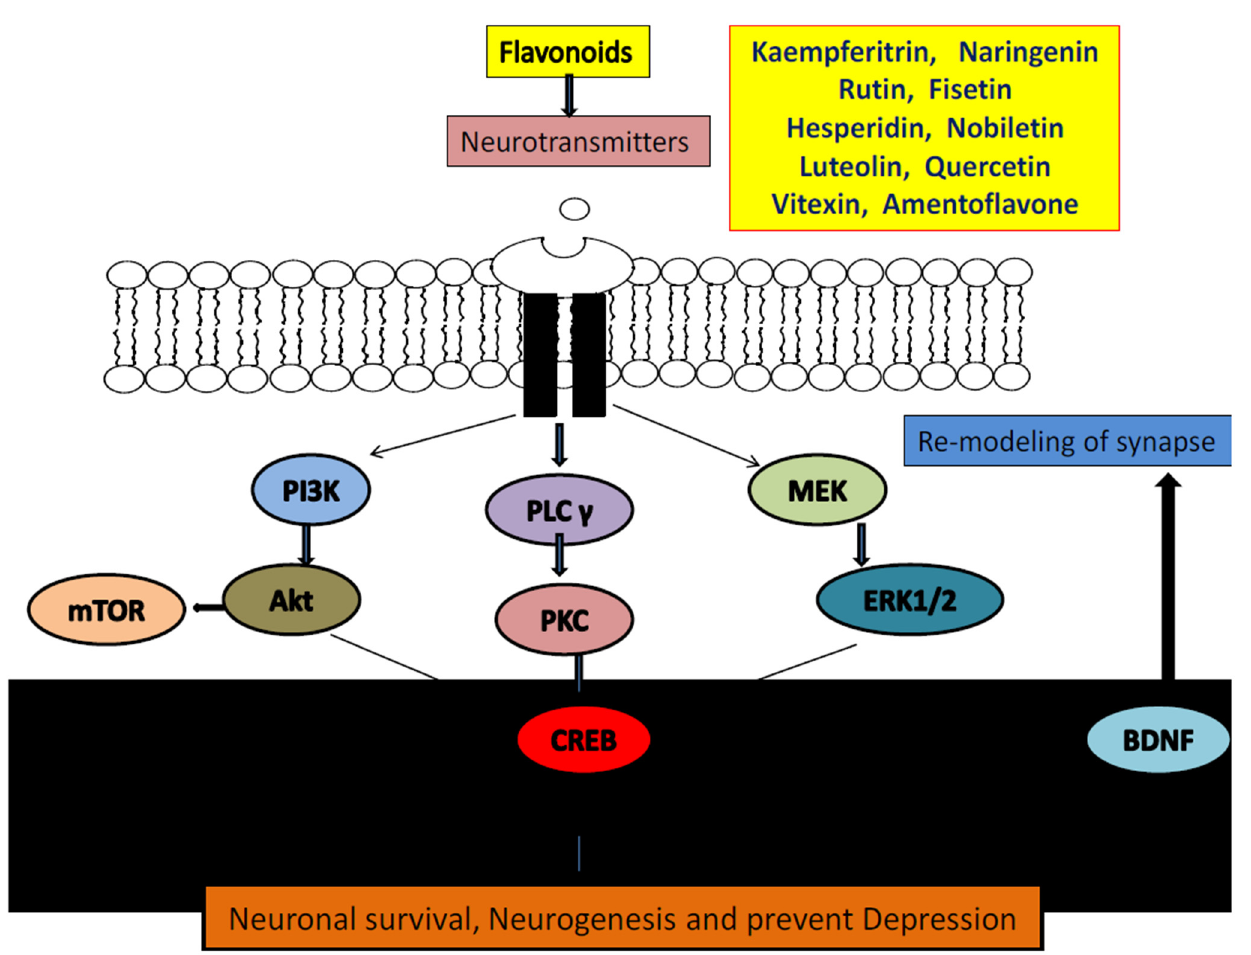
Figure 47. Effect of flavonoids on brain neurotransmitters . P13K, phosphoinositide 3-kinases; Akt (PKB), protein kinase B; mTOR, mammalian target of rapamycin; PLC γ , phospholipase C gamma; PKC, protein kinase C; MEK, mitogen-activated protein kinase; ERK1/2, extracellular regulated kinase 1 and 2; CREB, cAMP-response element binding protein; BDNF, brain-derived neurotrophic factor.